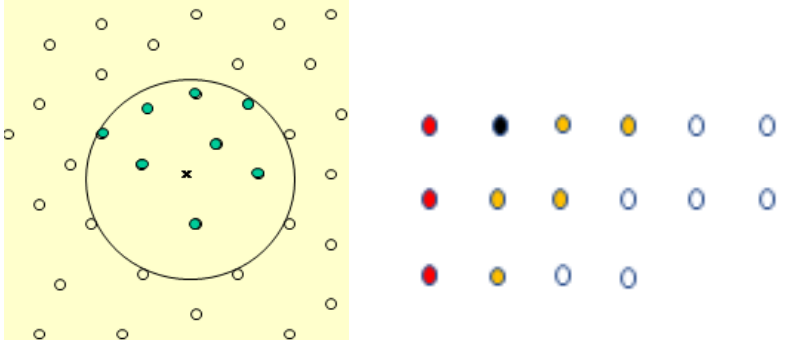
Figure 2. On the left , the distance criterion to choose the nodes of a star in the interior of Γ × [ 0, T ) where we choose the eight nearest nodes. On the right , the star is centered at a node of Γ × { t = T } (the star is centered at the black point, the yellow points belong to Γ × [ 0, T ) and the red ones to ∂ Γ × [ 0, T ]